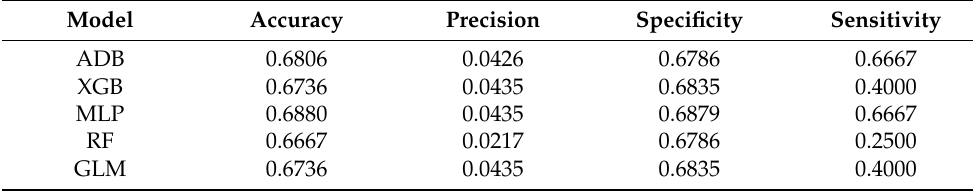
Table 4. Accuracy performance of various classifiers as meta-model.